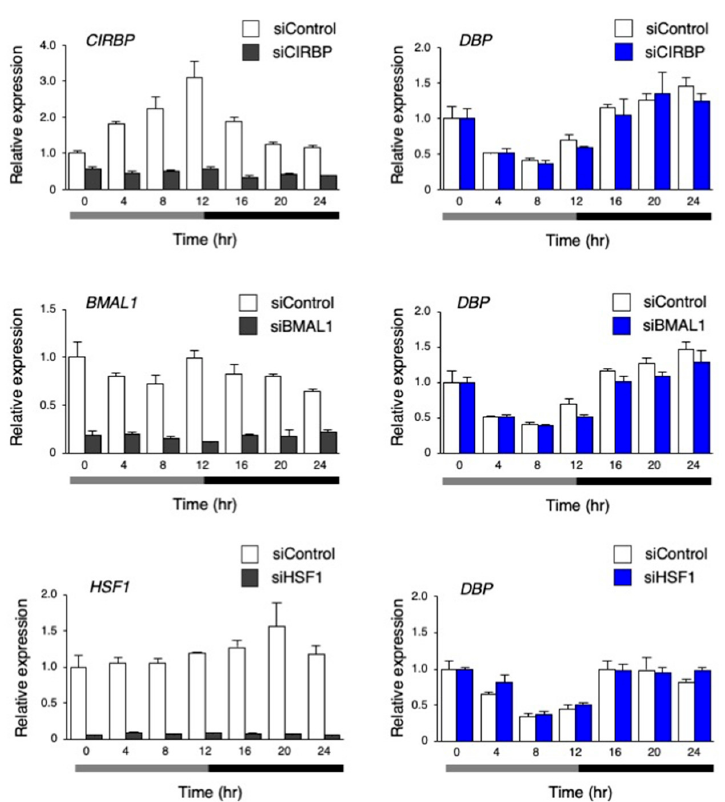
Figure 7. The effect of inhibiting the genes involved in the temperature rhythm-induced synchronization on the circadian-like rhythm of DBP expression. The expression levels of CIRBP , BMAL1 , HSF1, and DBP under the temperature rhythm in hiPSCs treated with siControl, siCIRBP, siBMAL1, or siHSF1; 0 h refers the start of day 5 of the temperature rhythm. The temperature was set at 33 °C from 0 to 12 h (gray bar) and then at 37 °C from 12 to 24 h (black bar). Data are presented as the means ± SEM. The left graph shows the relative value to 0 h of siControl, and the right graph shows relative value with respect to 0 h for siControl and the target siRNA; n = 3 for each comparison. The p values for the rhythmicity of CIRBP , BMAL1 , and HSF1 in the siControl-treated hiPSCs were determined by a cosinor analysis with p < 0.01, p = 0.84, and p = 0.16, respectively.